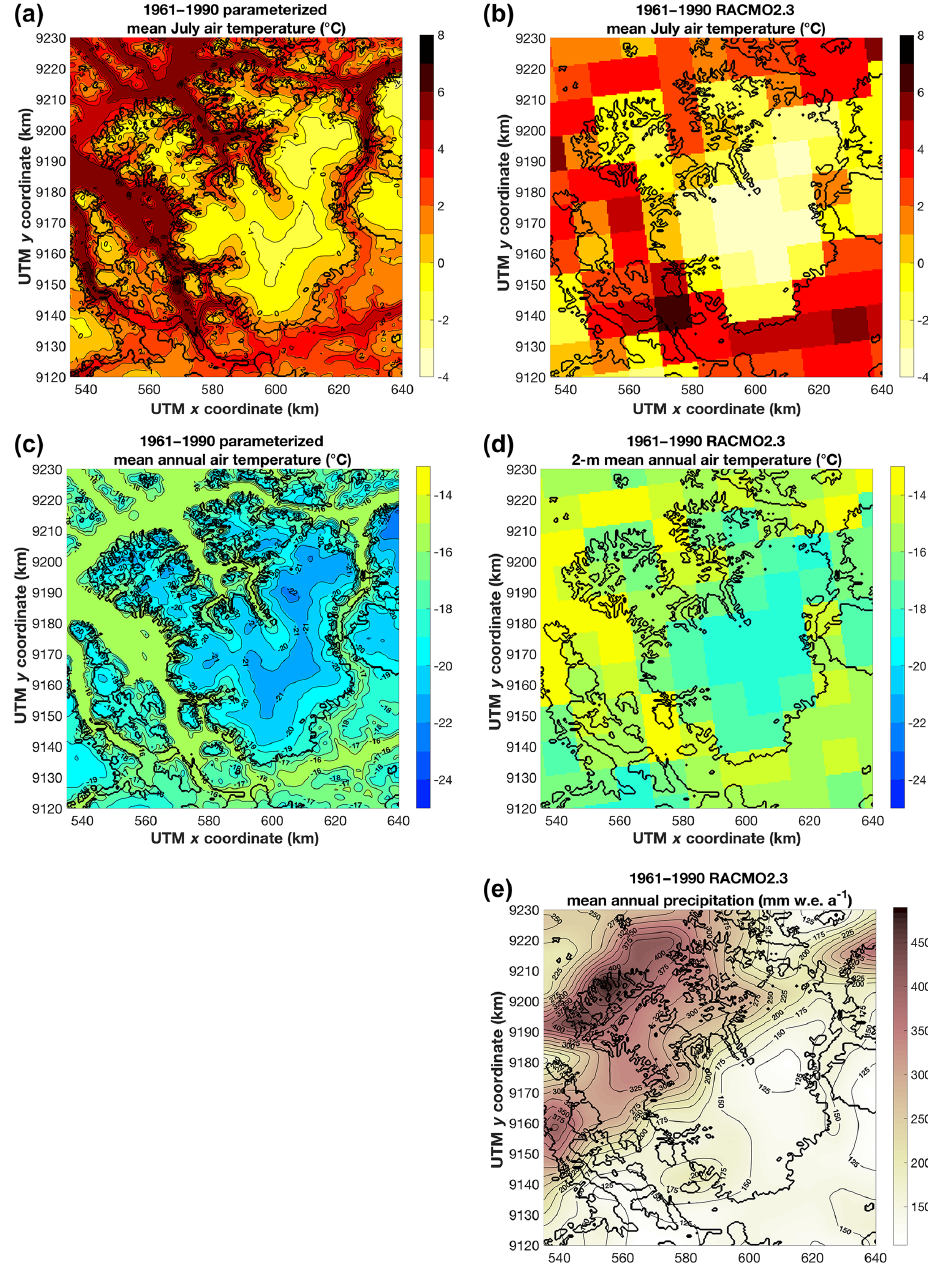
Figure 3. (a) 1961–1990 parameterized mean July temperature, (b) 1961–1990 RACMO2.3 mean July temperature (11km resolution), (c) 1961–1990 parameterized mean annual temperature, (d) 1961–1990 RACMO2.3 mean annual temperature (11km resolution)